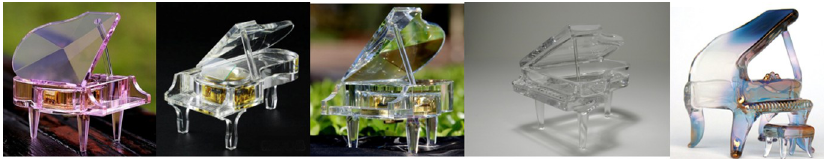
Fig 12. Five additional glass Pianos. VGG-19 incorrectly classified each of these five images despite correctly classifying the glass piano shown in Fig